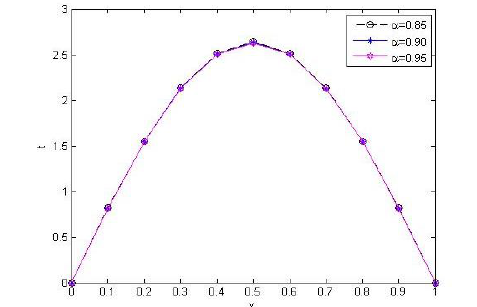
These solutions given by Table 4.